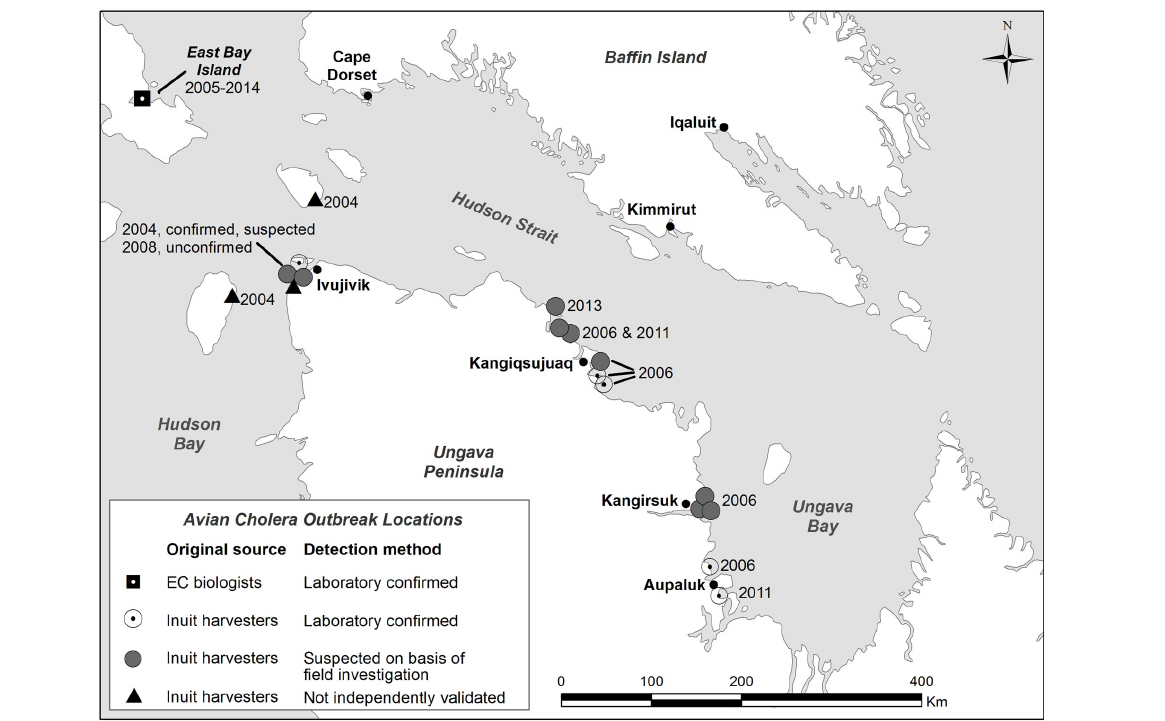
Fig. 1 . Location of avian cholera ( Pasteurella multocida ) outbreaks among Common Eiders ( Somateria mollissima ) in northeastern Hudson Bay, Hudson Strait, and Ungava Bay from 2004 to 2014. The original source of avian disease or mortality sighting and the detection methods used to confirm the presence of avian cholera are presented for each site (adapted from Iverson